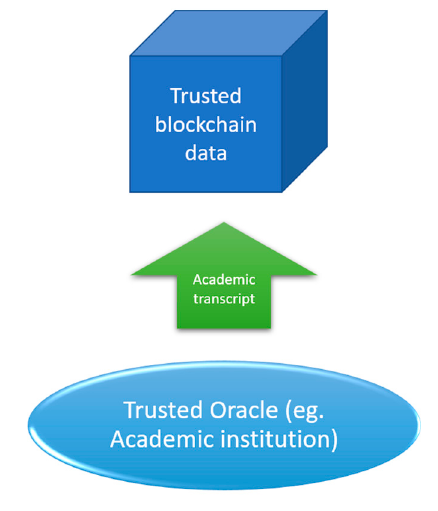
Figure 4. Academic institutions as trusted blockchain oracles.